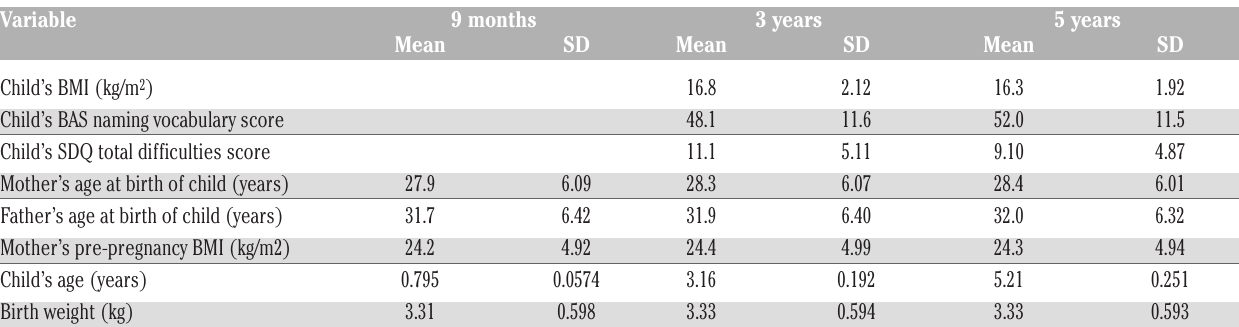
Table 2. Summary statistics for continuous variables.